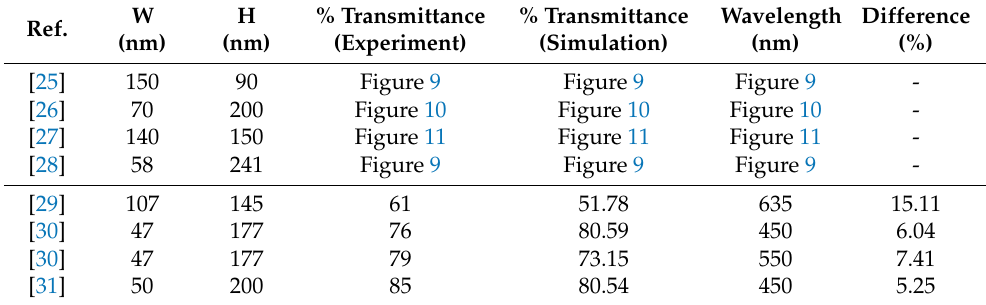
Figure 11. Comparison of our simulation and experimental results [27] using Al fiber (W = 58 nm and H = 241 nm). Table 1. The conclusion of comparison of our simulation with the experimental results. Ref.